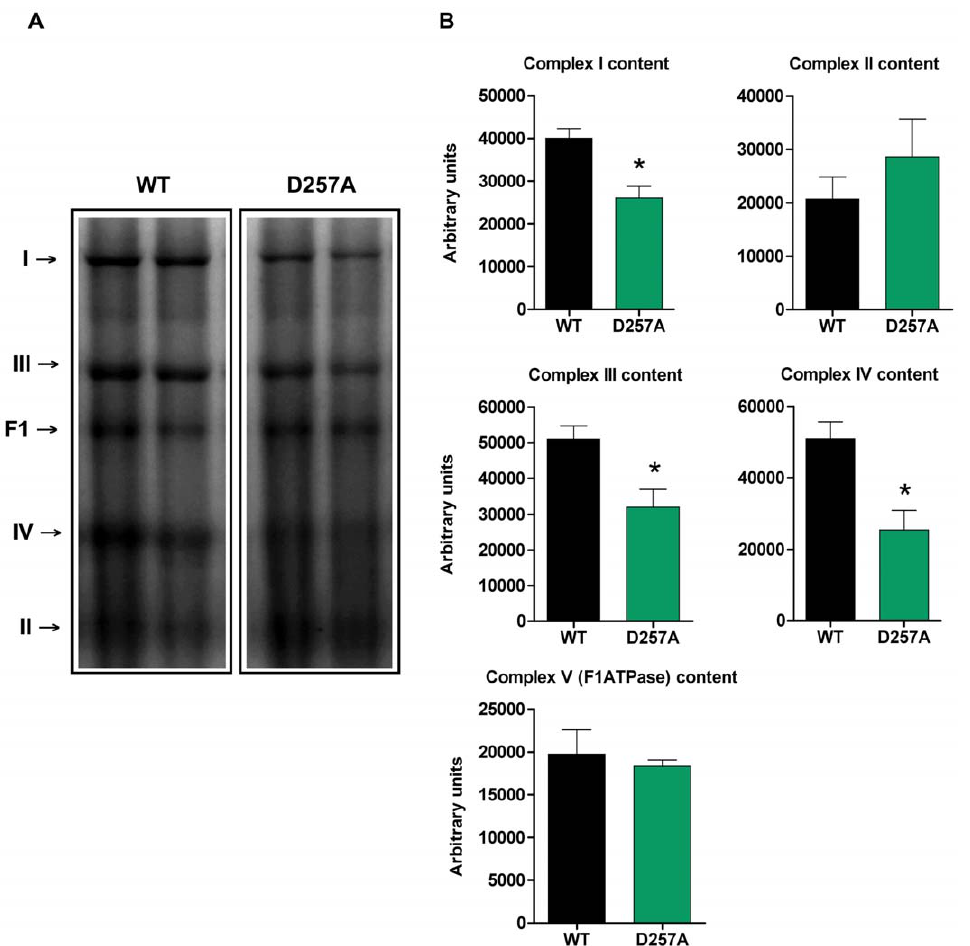
Figure 3. D257A mice display decreased content of ETC Complexes I, III and IV compared to WT. (A) The total content of ETC complexes I, II, III, IV and the F1 domain of the ATPase from skeletal muscle of 11-mo old WT and D257A mice (n=7 per group) was determined using Blue Native PAGE electrophoresis followed by staining with commassie blue stain. Proteins were separated according to molecular weight. Representative blots are depicted. (B) Statistical analysis of ETC complexes content. Arbitrary units represent densitometry values normalized to total protein loaded measured by the Bradford assay. Mean values 6 SEM are shown. *p , 0.01.